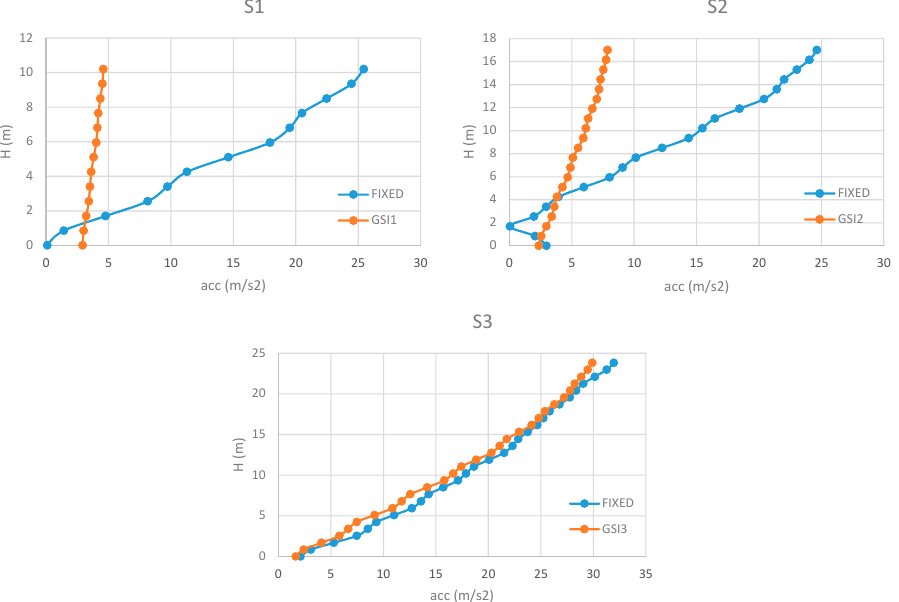
Figure 9. Maximum accelerations along the height (IM1).